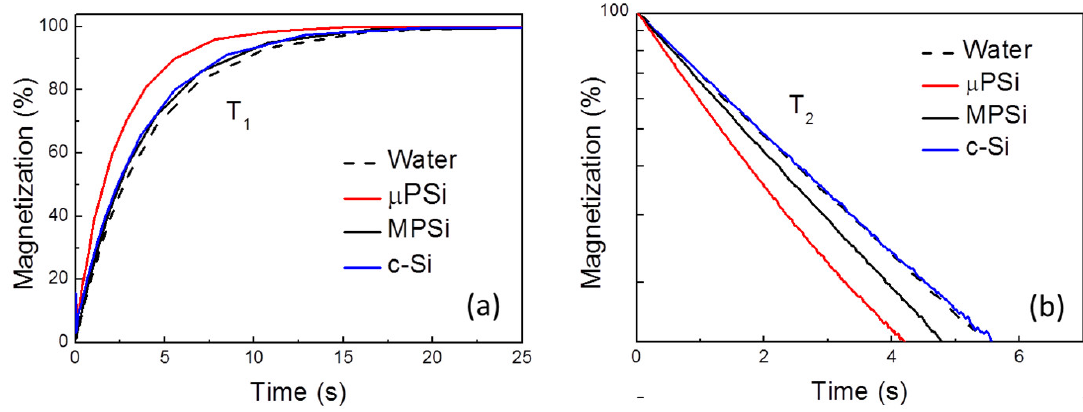
Figure 37. Transients of ( a ) longitudinal and ( b ) transverse proton magnetization of pure water (black dashed line) and aqueous suspensions of NPs (1g/L) prepared from c-Si (blue line) MPSi (black line) and µ PSi (red line). (Reprinted from Reference [96] by permission from John Wiley and Sons © 2018).